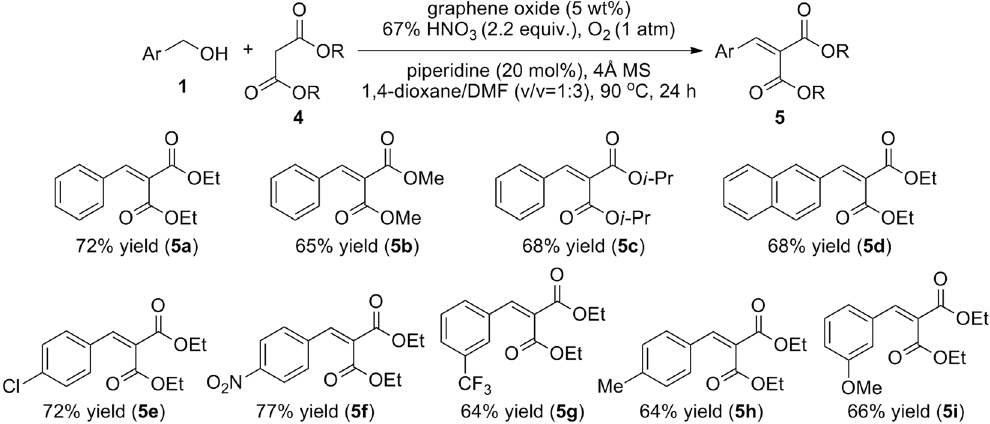
Figure 6. Reaction scope for a variant of the Knoevenagel condensation via cooperative catalysis.